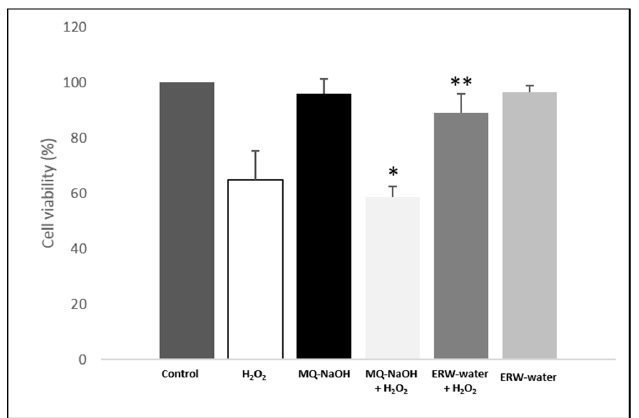
Figure 1. Cytotoxic effect ERW-medium on U937 cells line. Cells were grown in an MQ-medium or MQ-NaOH medium or ERW-medium with/without H 2 O 2 and subjected to an MTT assay to analyse cell cytotoxicity. Data is presented as means ± SD for triplicate experiments. * p < 0.05 vs. MQ-NaOH; ** p < 0.05 vs. MQ-NaOH + H 2 O 2 .